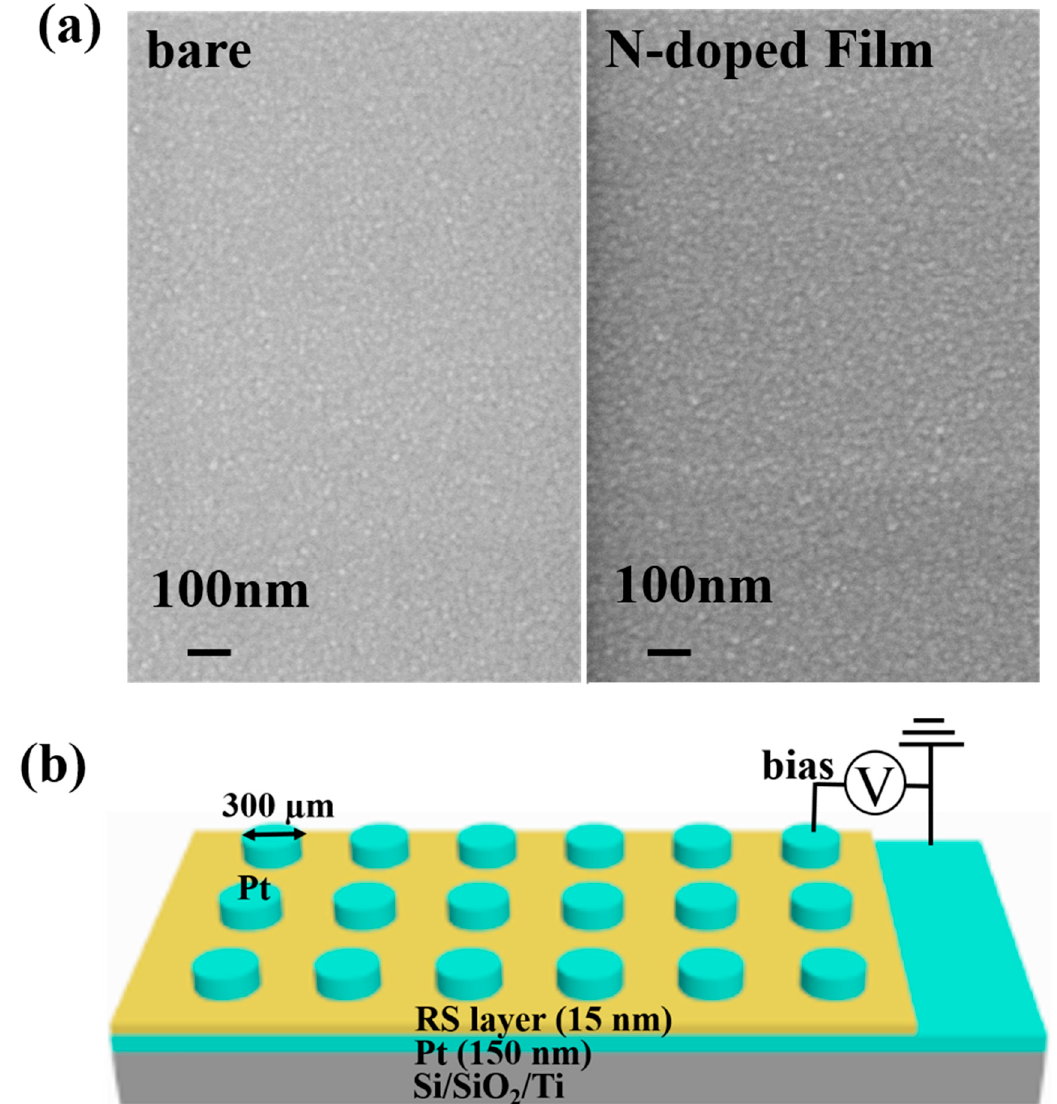
Figure 2. ( a ) Surface morphologies of bare NbO x and N-doped films. ( b ) Schematic diagram of the Pt/RS layer/Pt memory device (RS layer: NbO x or NbO x :N).